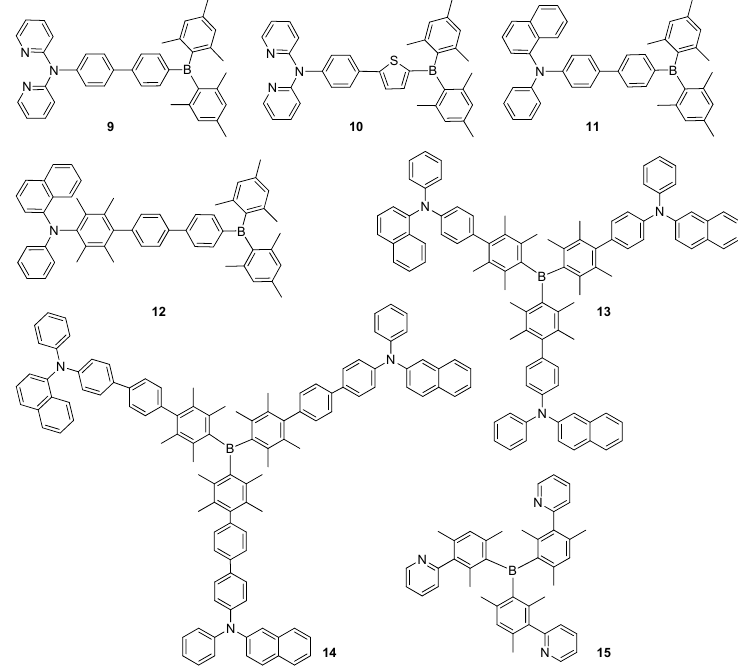
Figure 5. Triarylborane-based conjugated D–A type materials 9 – 15 .